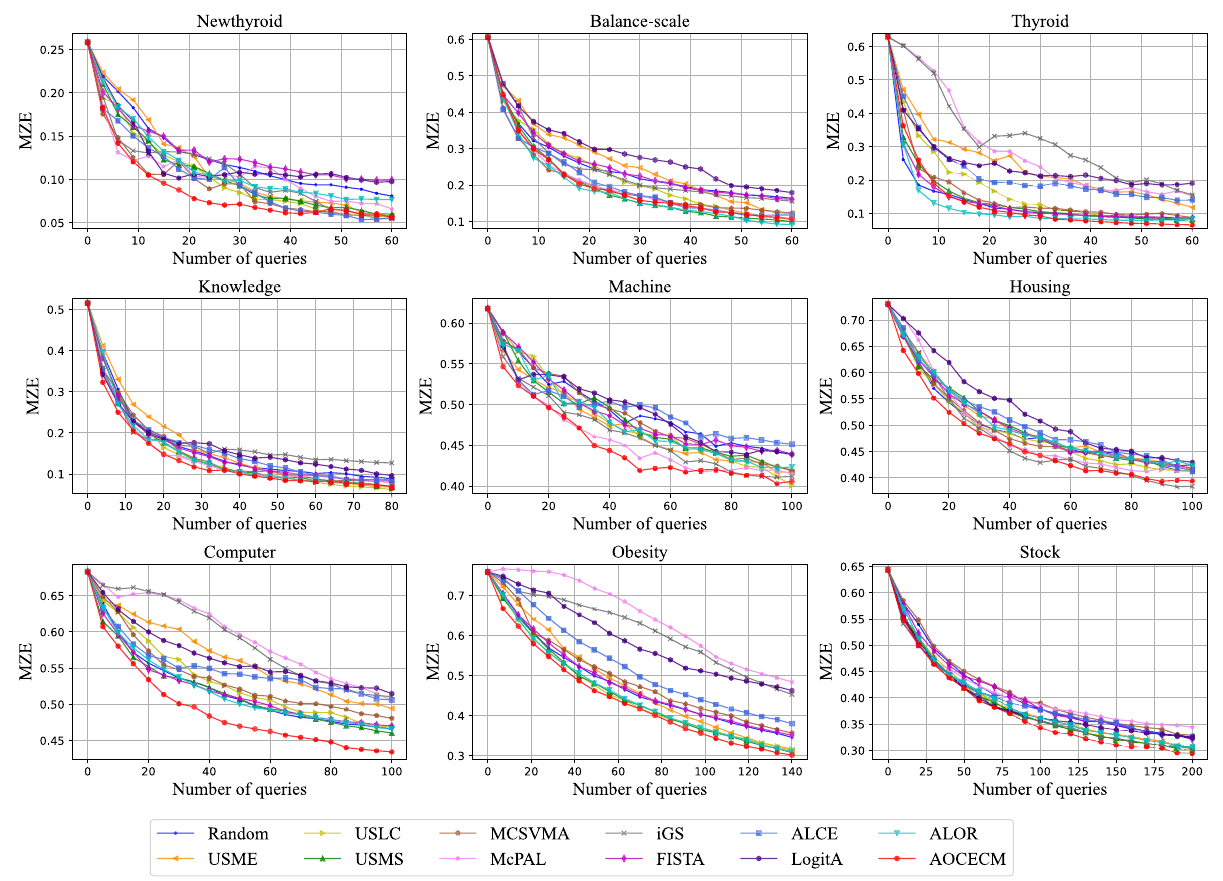
Figure 3. Learning curves of MZE for the twelve compared